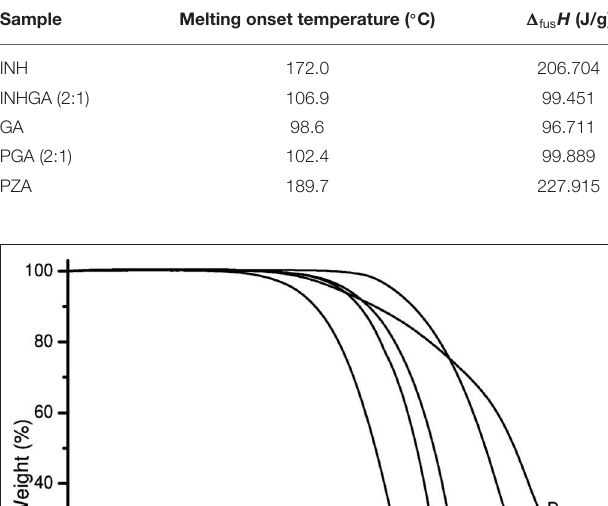
TABLE 1 | Thermal properties for pure INH, PZA, GA, and the two co-crystals INHGA (2:1) and PGA (2:1) from DSC analyses. Sample